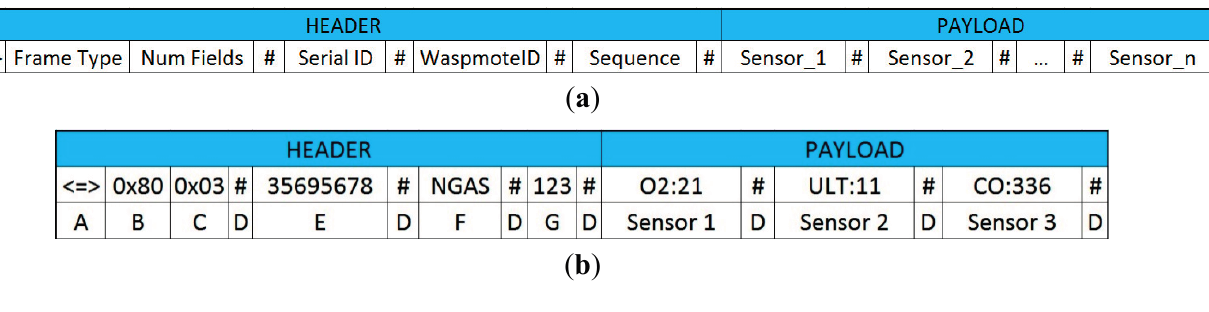
Figure 12. ASCII frame. ( a ) Frame structure; ( b ) Example with sensor data.